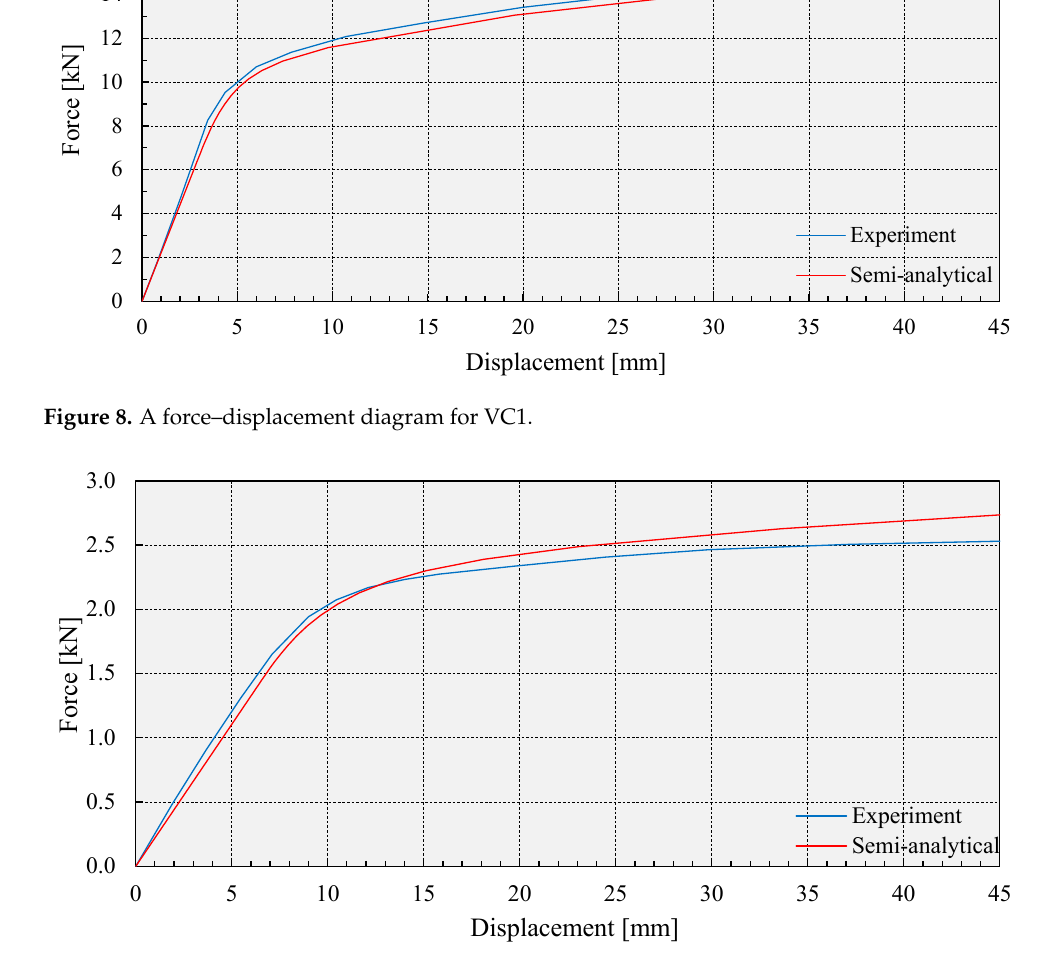
Figure 9. A force–displacement diagram for VC2.